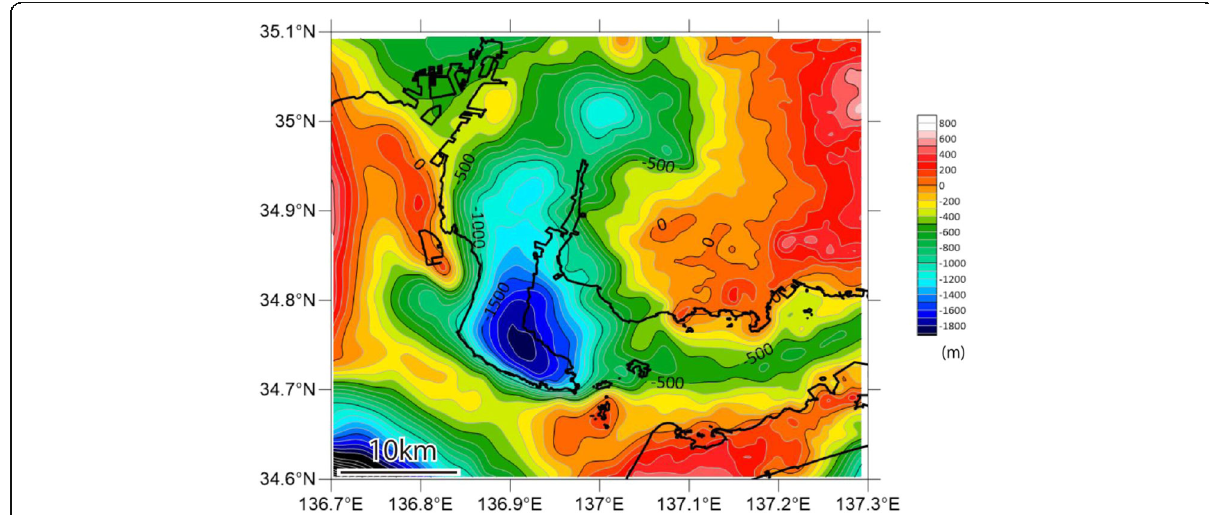
Fig. 7 Gravity basement map obtained using the relationship between the depth of the basement and the residual Bouguer anomaly (Fig. 5) based on the residual Bouguer anomaly map (Fig.